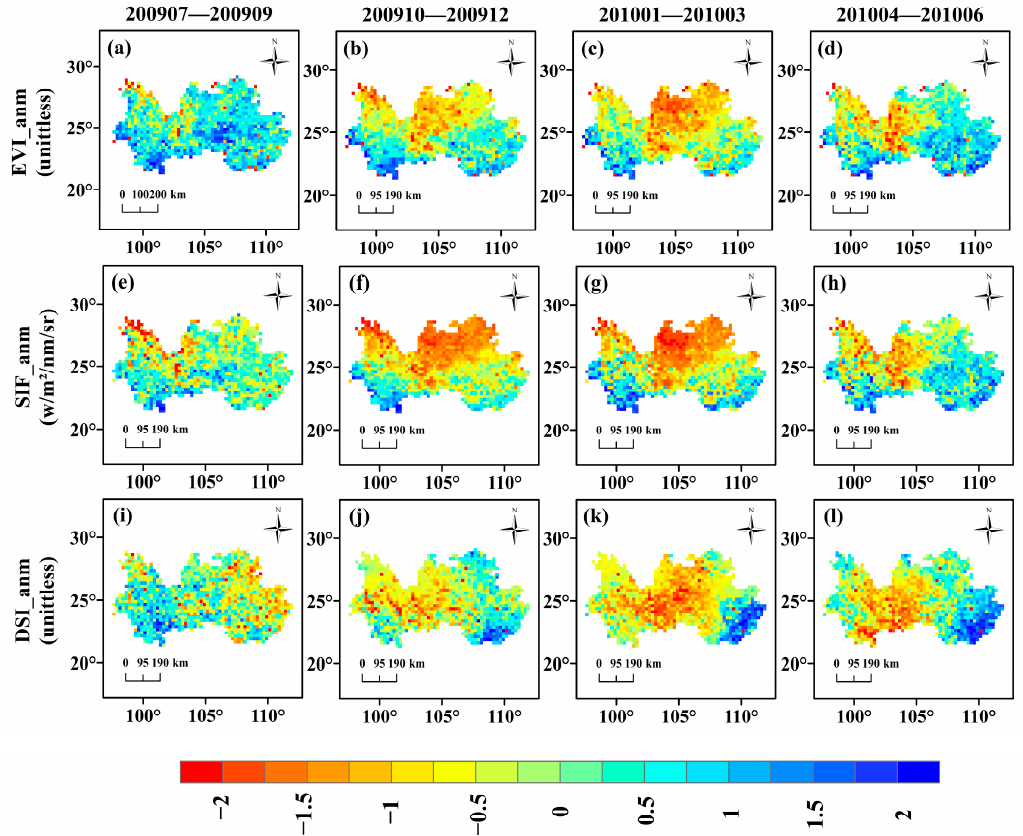
Figure 6. The spatial distributions of the anomalies of ( a – d ) EVI, ( e – h ) SIF, and ( i – l ) DSI over three provinces in July–September (first column), October–December (second column), January–March (third column), and April–June (fourth column) in 2009–2010. Correlation analysis between SIF and meteorological indicators (P, ET, SWC), which derived three maps of correlation coefficients (Figure 7). The SIF anomalies show a strong positive correlation with P anomalies in Southwest China (R 2 = 0.74, p < 0.05) (Figure 7b), suggesting that precipitation deficit may directly lead to negative SIF in this drought event. Therefore, the relationships between SWC and SIF anomalies are shown in Figure 7b. It shows that SIF was positively related to the of SWC (R 2 = 0.38, p < 0.05) (Figure 7b) and ET (R 2 = 0.74, p < 0.05) (Figure